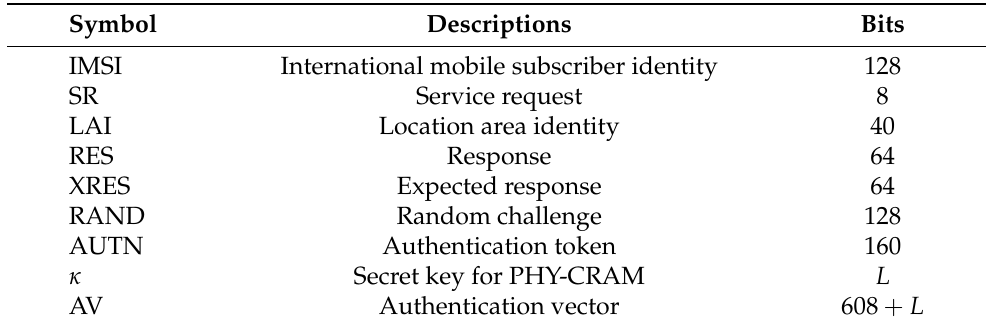
Table 1. Related